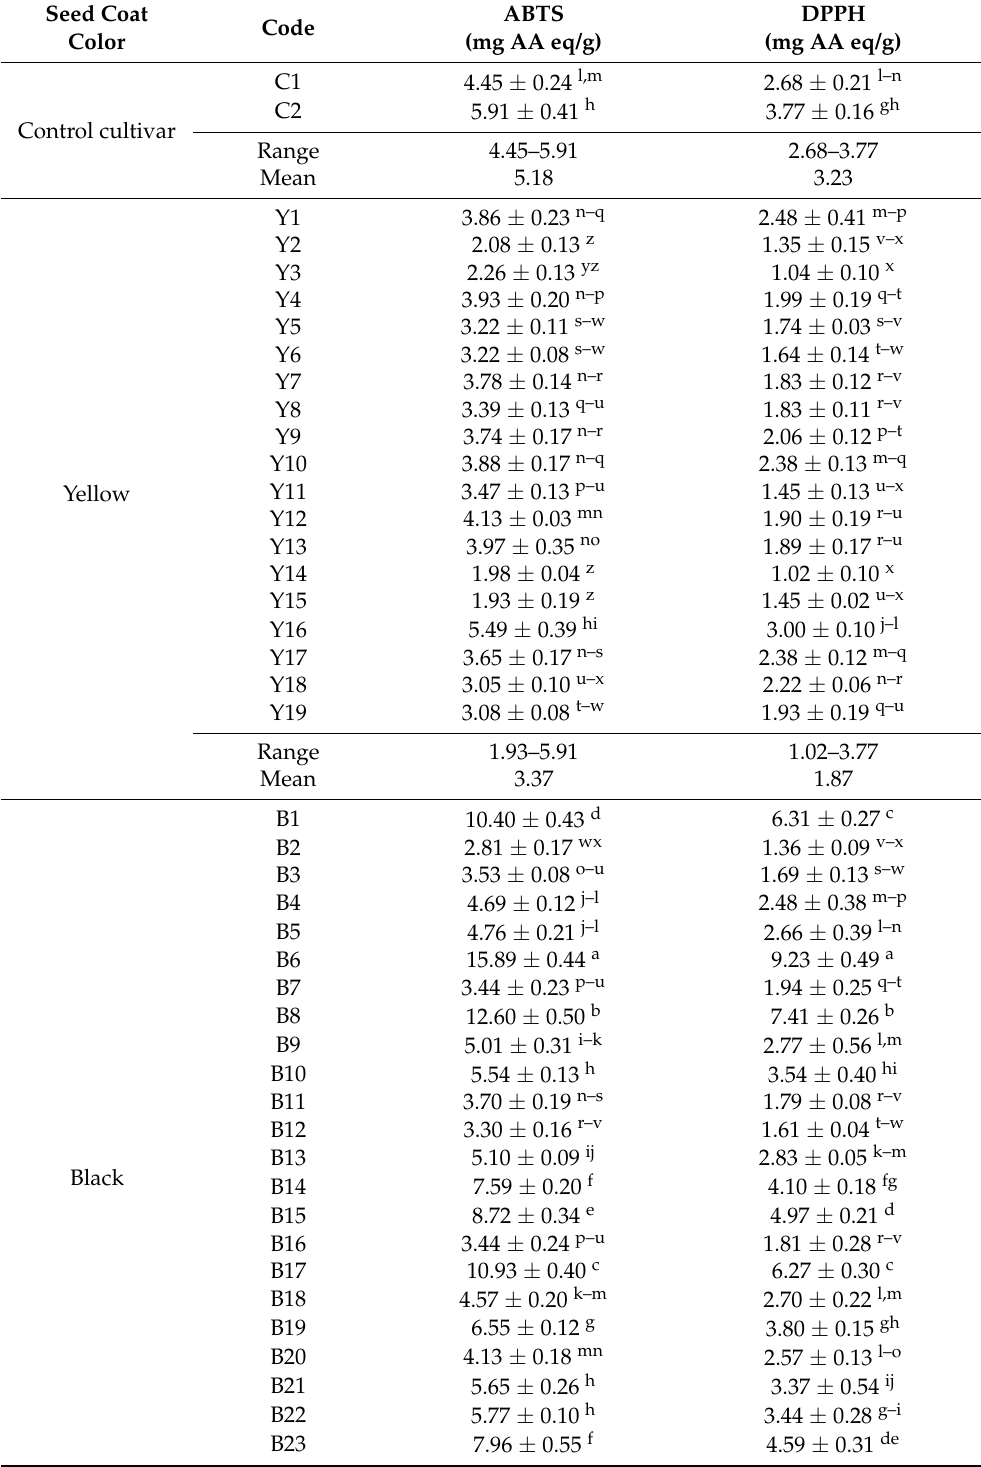
Table 3. ABTS and DPPH radical scavenging activities in soybean